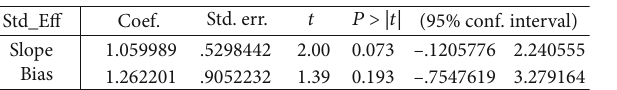
Figure 11: Egger ’ s